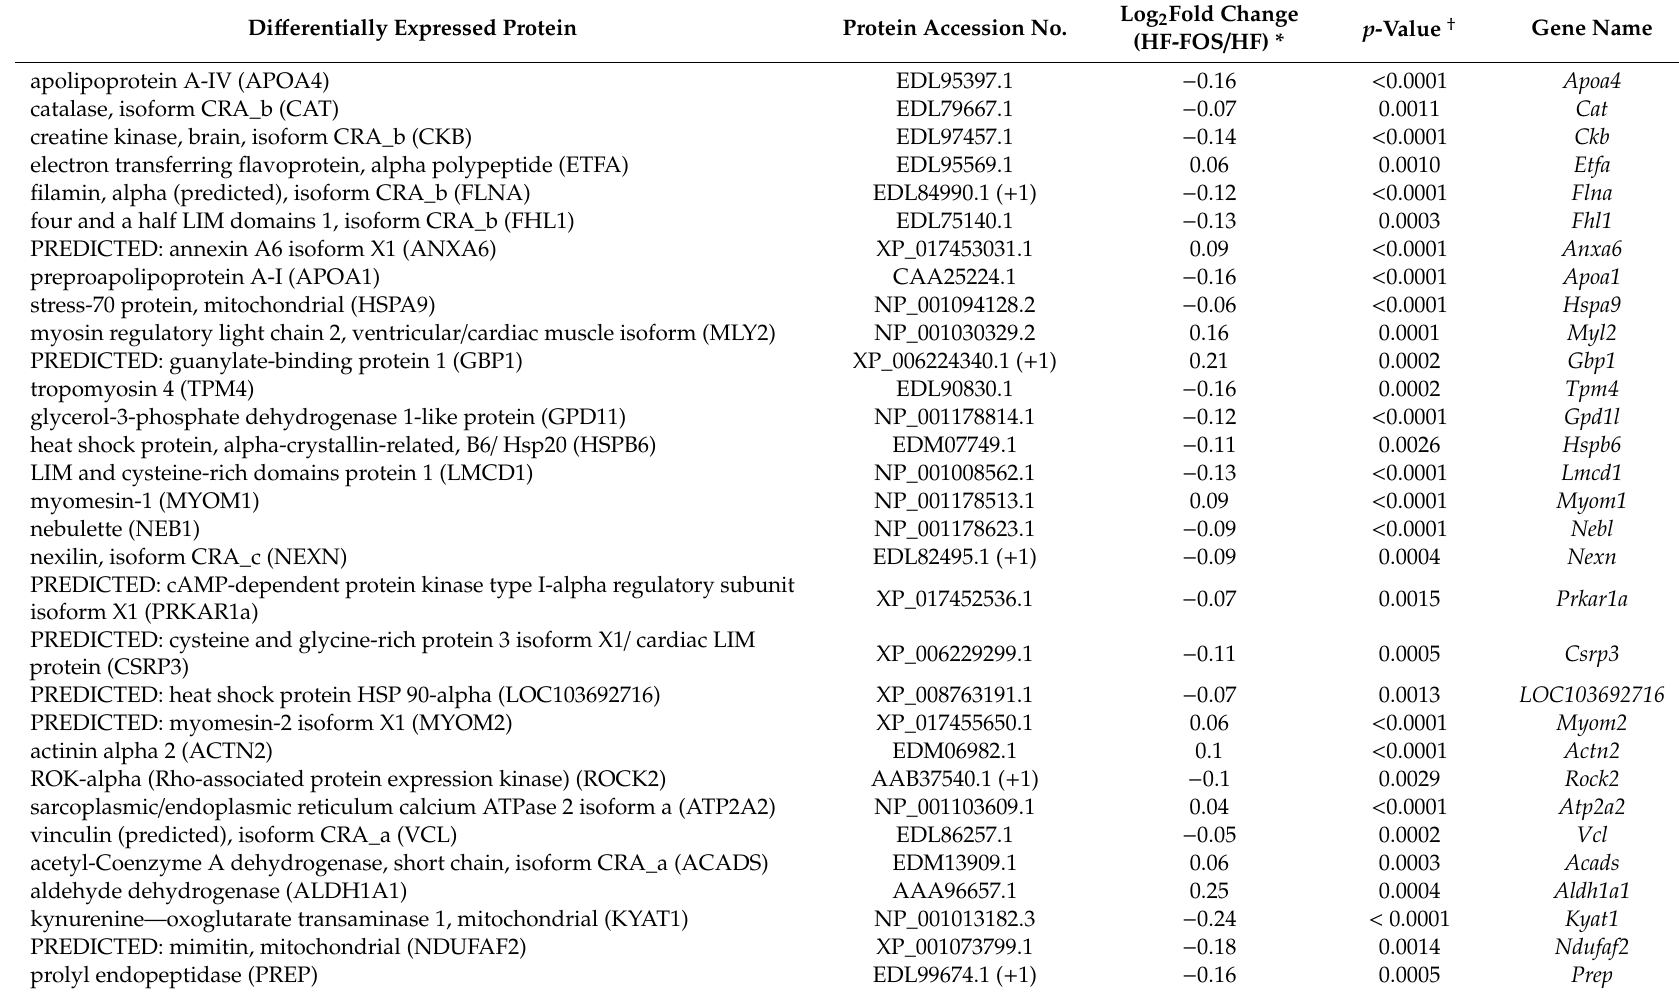
Table 3. Di ff erentially expressed proteins in heart tissue following high-fat with fructooligosaccharide vs. high-fat treatments. Di ff erentially Expressed Protein Protein Accession